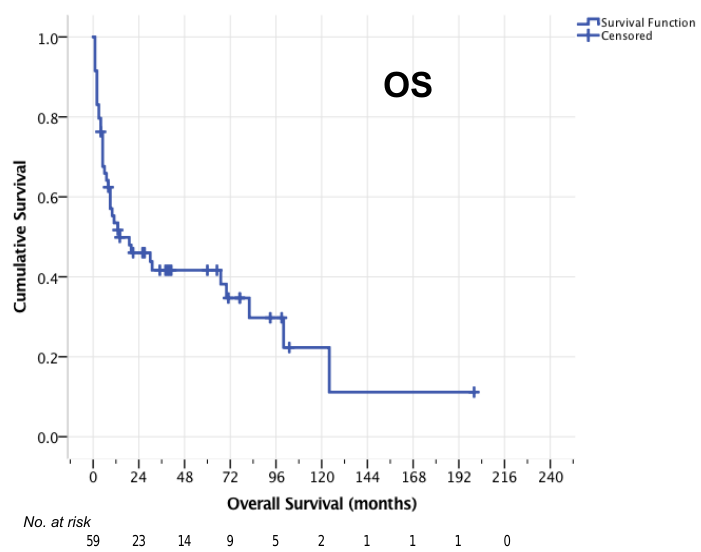
Figure 2. OS of the entire cohort ( n = 59).